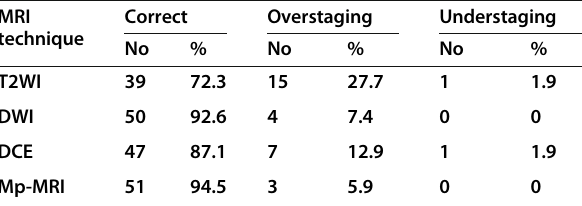
Table 1 Diagnostic T staging performance of the different sequences and mp-MRI MRI technique